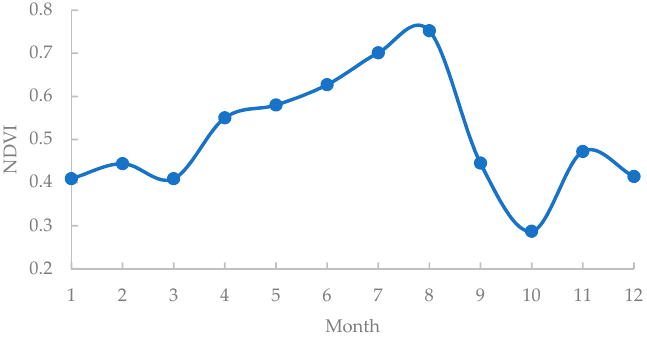
Figure 6. Changes in monthly mean MODIS-NDVI values in the Wenchuan